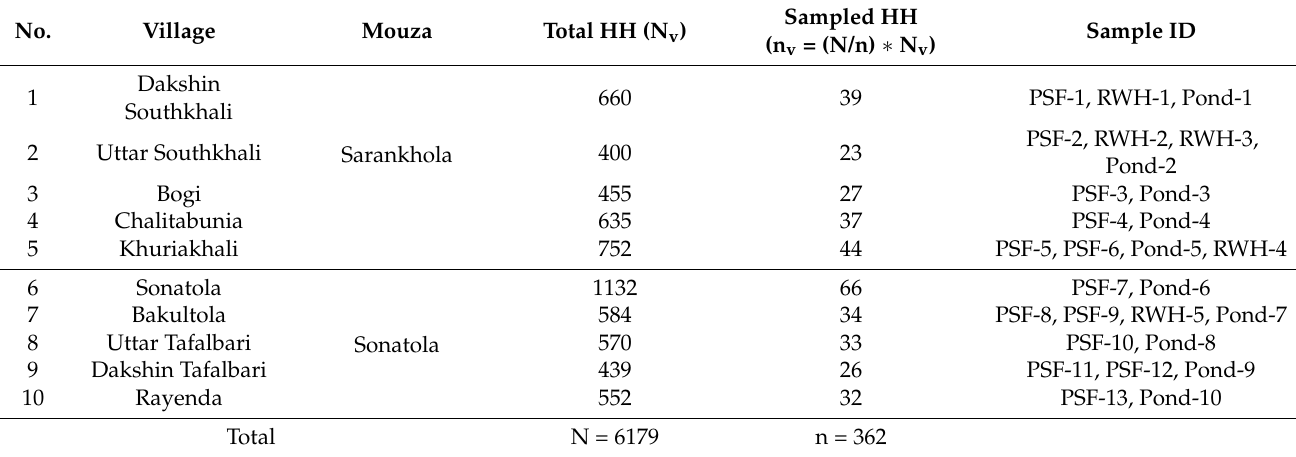
Table 1. Sampled sources and the number of respondents from different